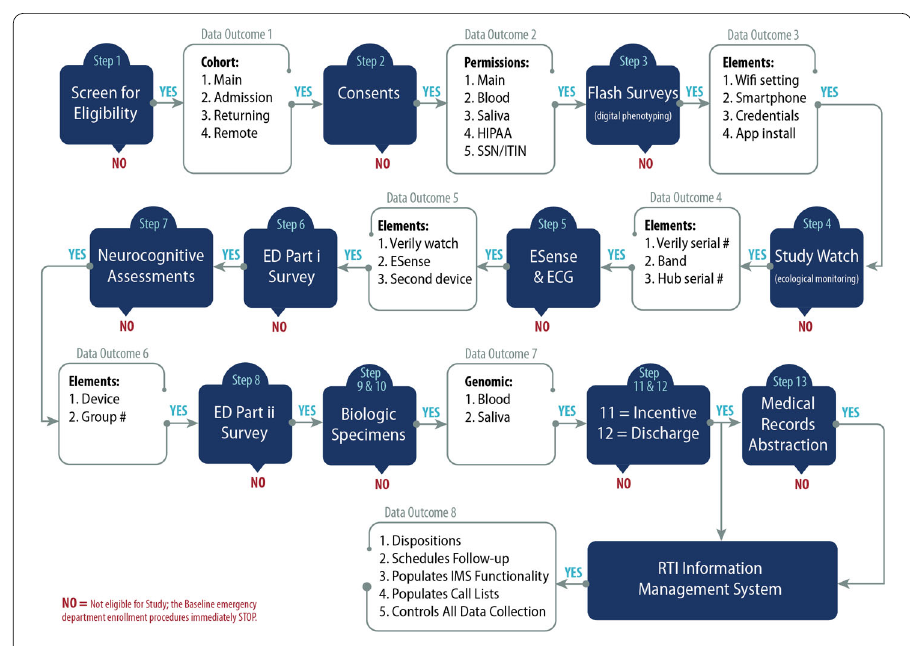
Figure 1 Baseline data streams. An integrated baseline program encompassing scripts, questions, graphics, instructions, and big data linkages to ease ED 3-hour protocol to incorporate phenotypic, clinical, physiological, sensor, environmental, ecological, and medical data measures Table 3 Data-driven events and individual participant